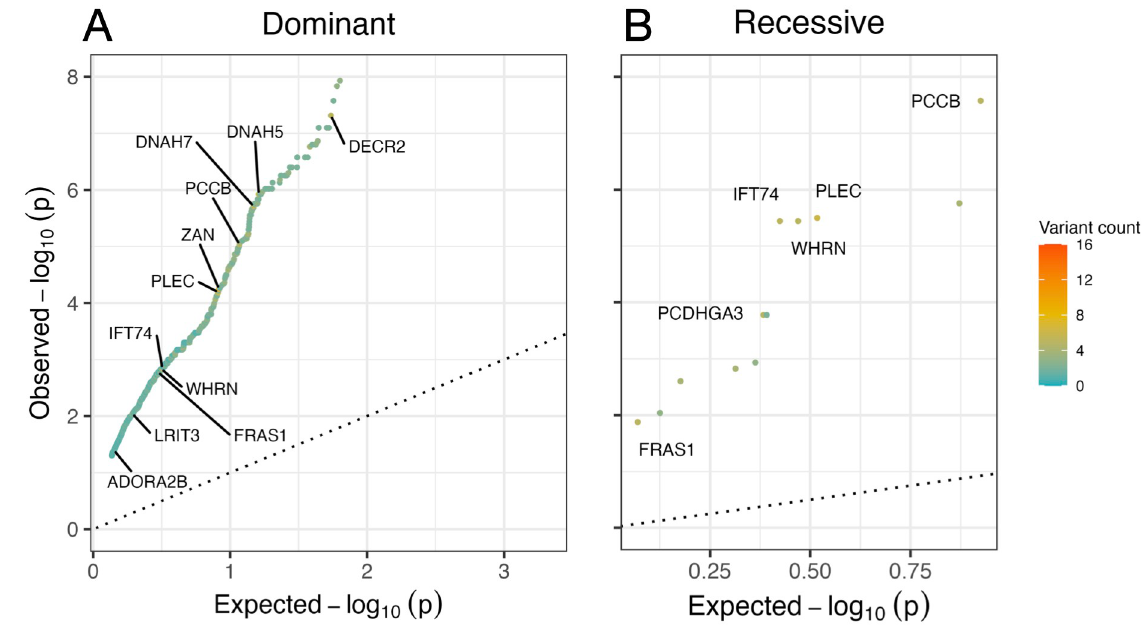
Fig 3. Gene-based mutational burden analysis was performed on individual samples. Based on allele frequencies from the cholesteatoma and control (gnomAD) cohort variants were split into dominant (A) and recessive (B) groups. The dot colour indicates the number of variants counted across the total cholesteatoma cohort, blue indicates a variant count of 0, and orange with a maximum count of 16. Statistical differences were determined using a two-sided exact Fisher’s exact test ( p < 0.05). Points labelled with gene names have greater than 5 candidate variants in common across all samples. Refer to S3 Data for a comprehensive list of TRAPD